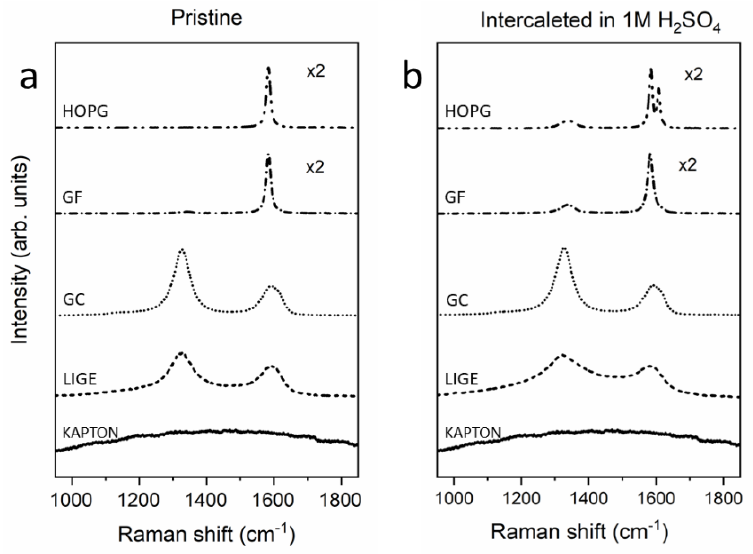
Figure 4. Raman spectra of electrodes in pristine condition ( a ) and after the EC treatment ( b ).